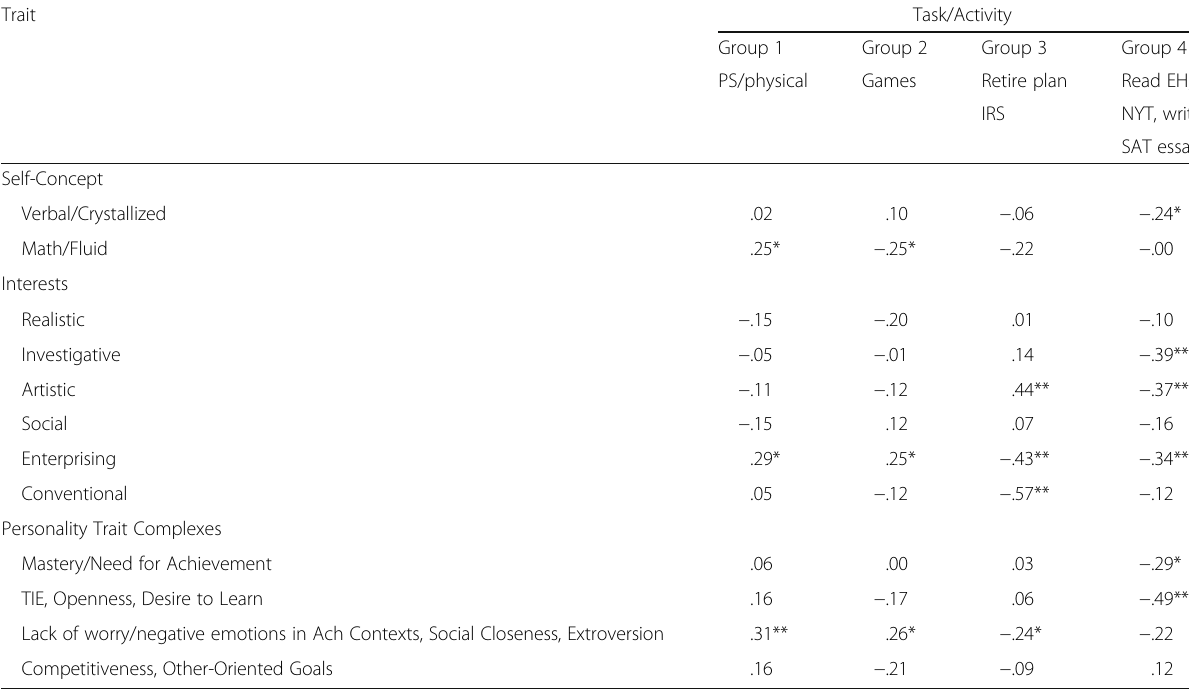
Table 4 Trait correlates of task/activity preferences